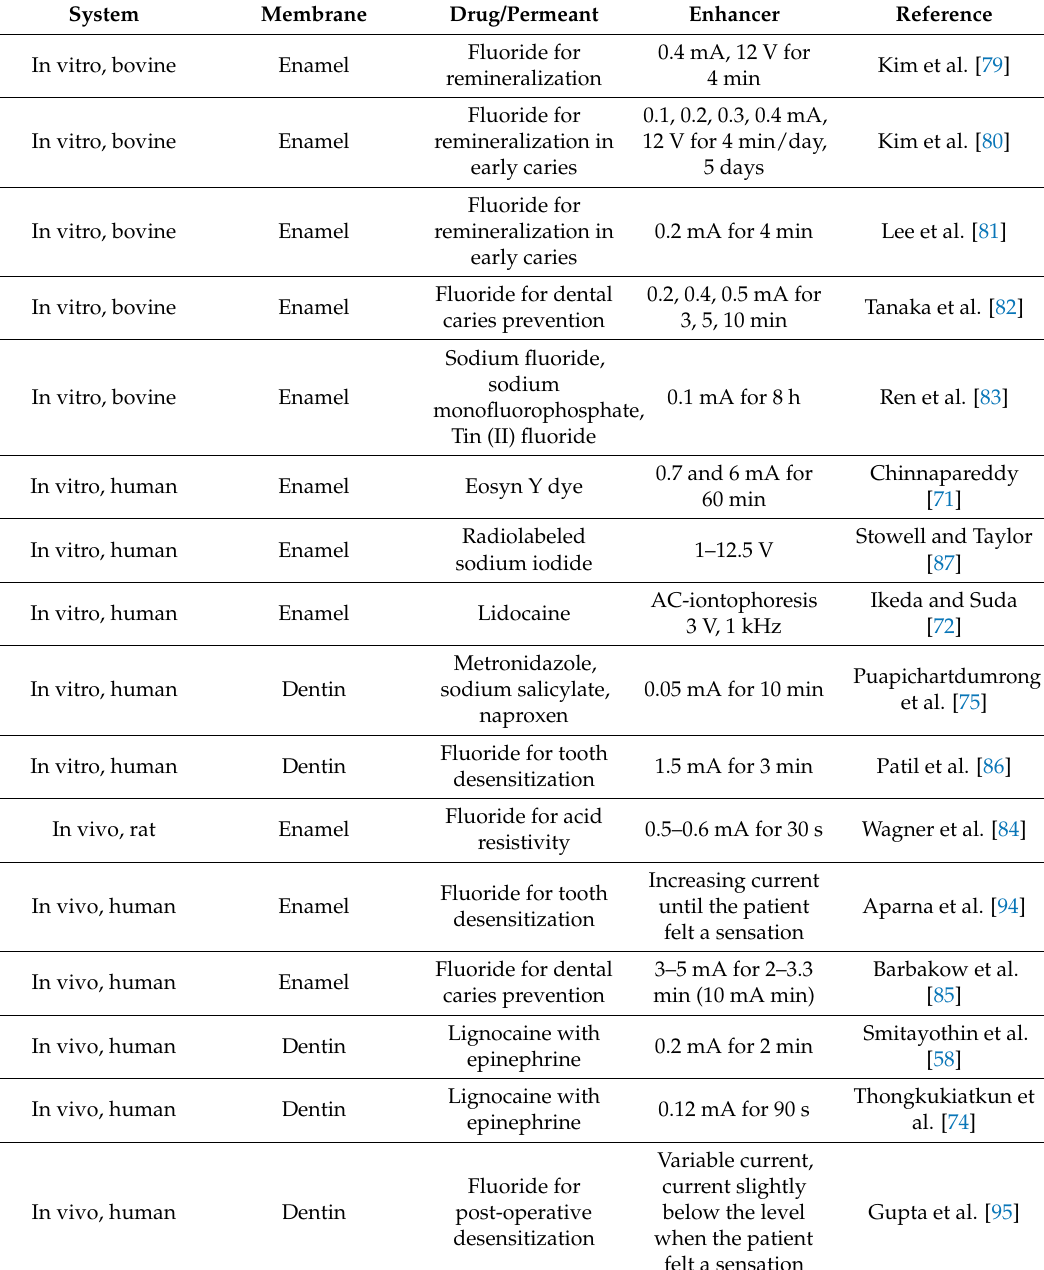
Table 3. Summary of studies on iontophoresis in hard tissue in the oral cavity.